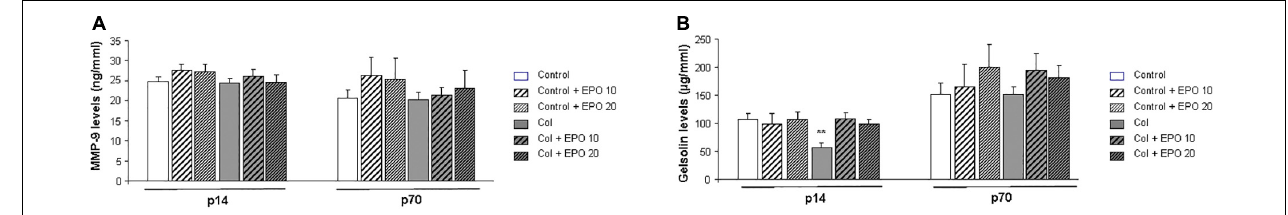
FIGURE 5 | Effect of EPO treatment on peripheral markers of GM-IVH. (A) EPO treatment does not affect MMP9 plasma levels at P14 ( p = 0.633) or P70 ( p = 0.453). (B) EPO treatment restores plasma gelsolin levels after inducing a GM-IVH in the short term, while differences are no longer detected in the long term (P70) (P14 ** p = 0.002 vs. rest of the groups, P70 p =